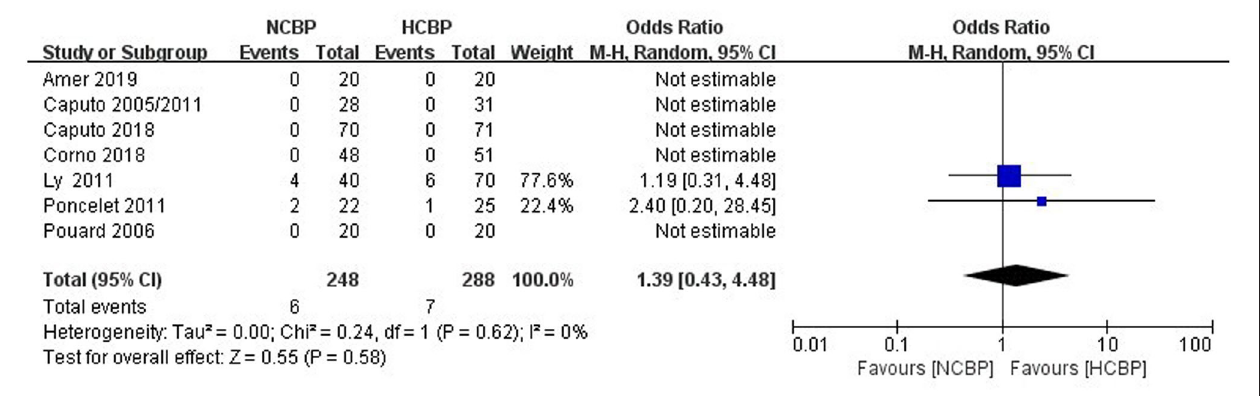
FIGURE 2 | Pooled analysis for the comparison of the risk of death.